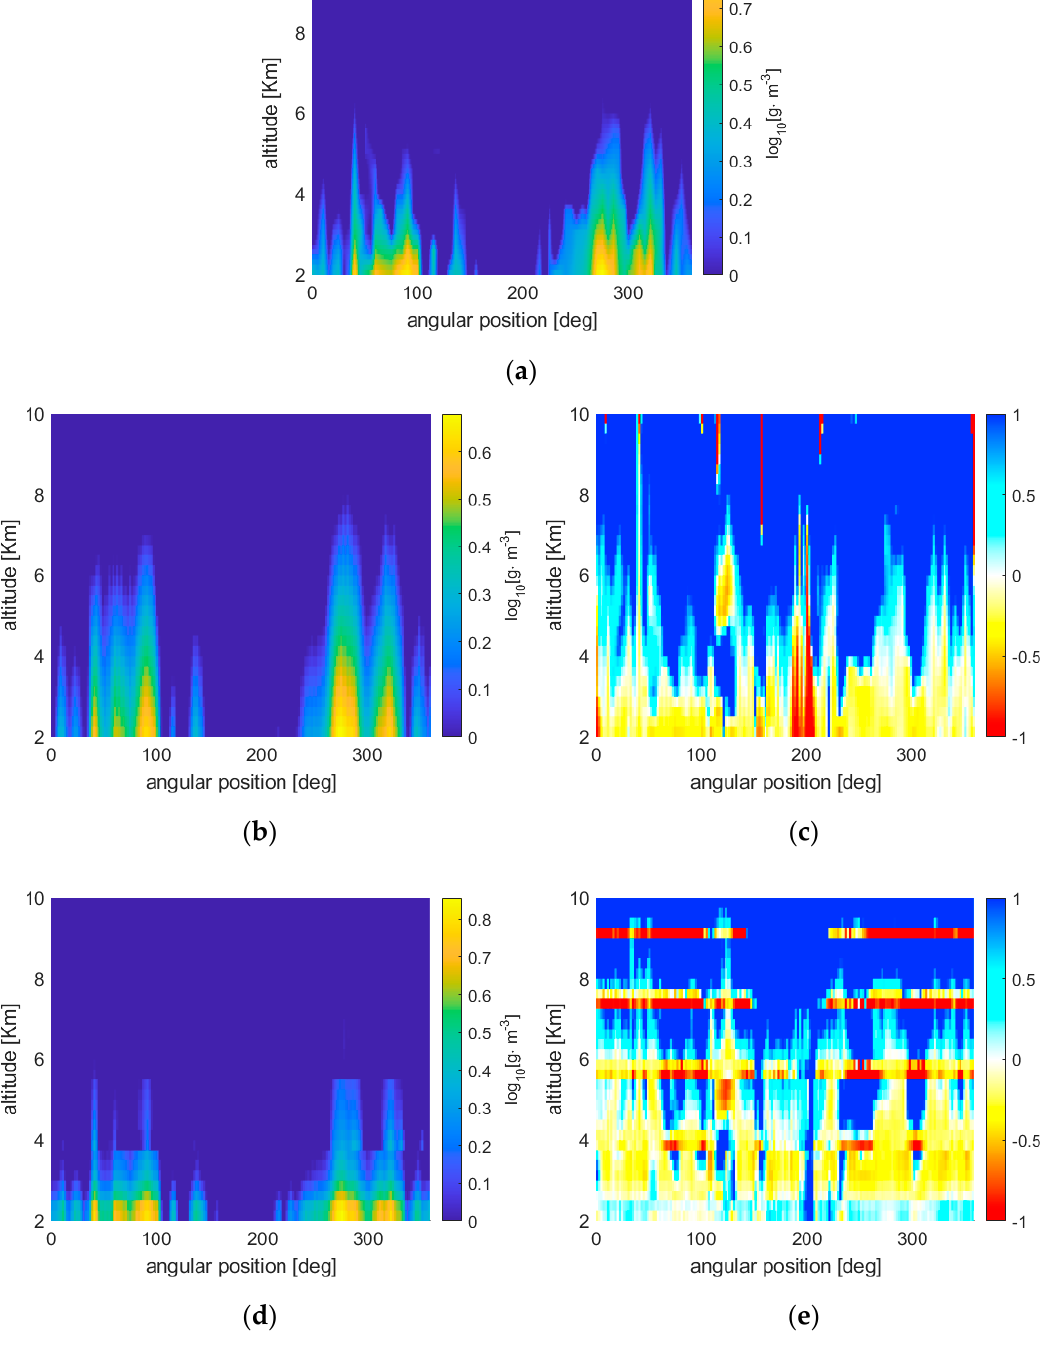
Figure 4. ( a ) True WV field (ECMWF analysis T511 L91 of 15 January 2011 taken at 20 ◦ longitude East) as a function of angle and altitude; ( b ) retrieved WV field with ERTA and ( c ) the corresponding normalized error field; ( d ) retrieved WV field with LSATR and ( e ) the corresponding normalized error field defined as in Equation (17). The angular coordinate has the origin in the North Pole and descends along the 20 ◦ East longitude meridian. Satellite configuration: 1Tx ‐ 5Rx.